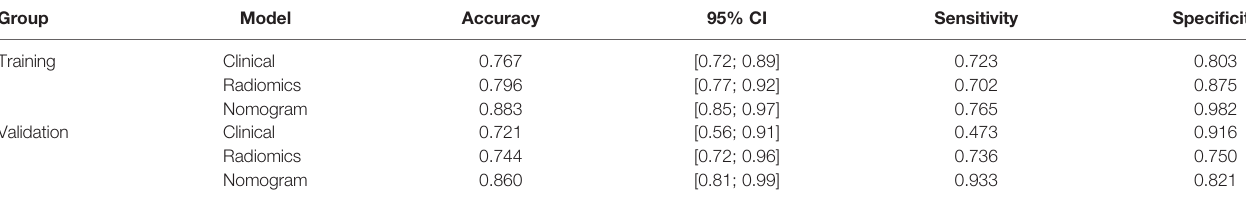
TABLE 2 | Predictive performance outcomes of the radiomic nomogram, radiomic algorithm, and clinical model.